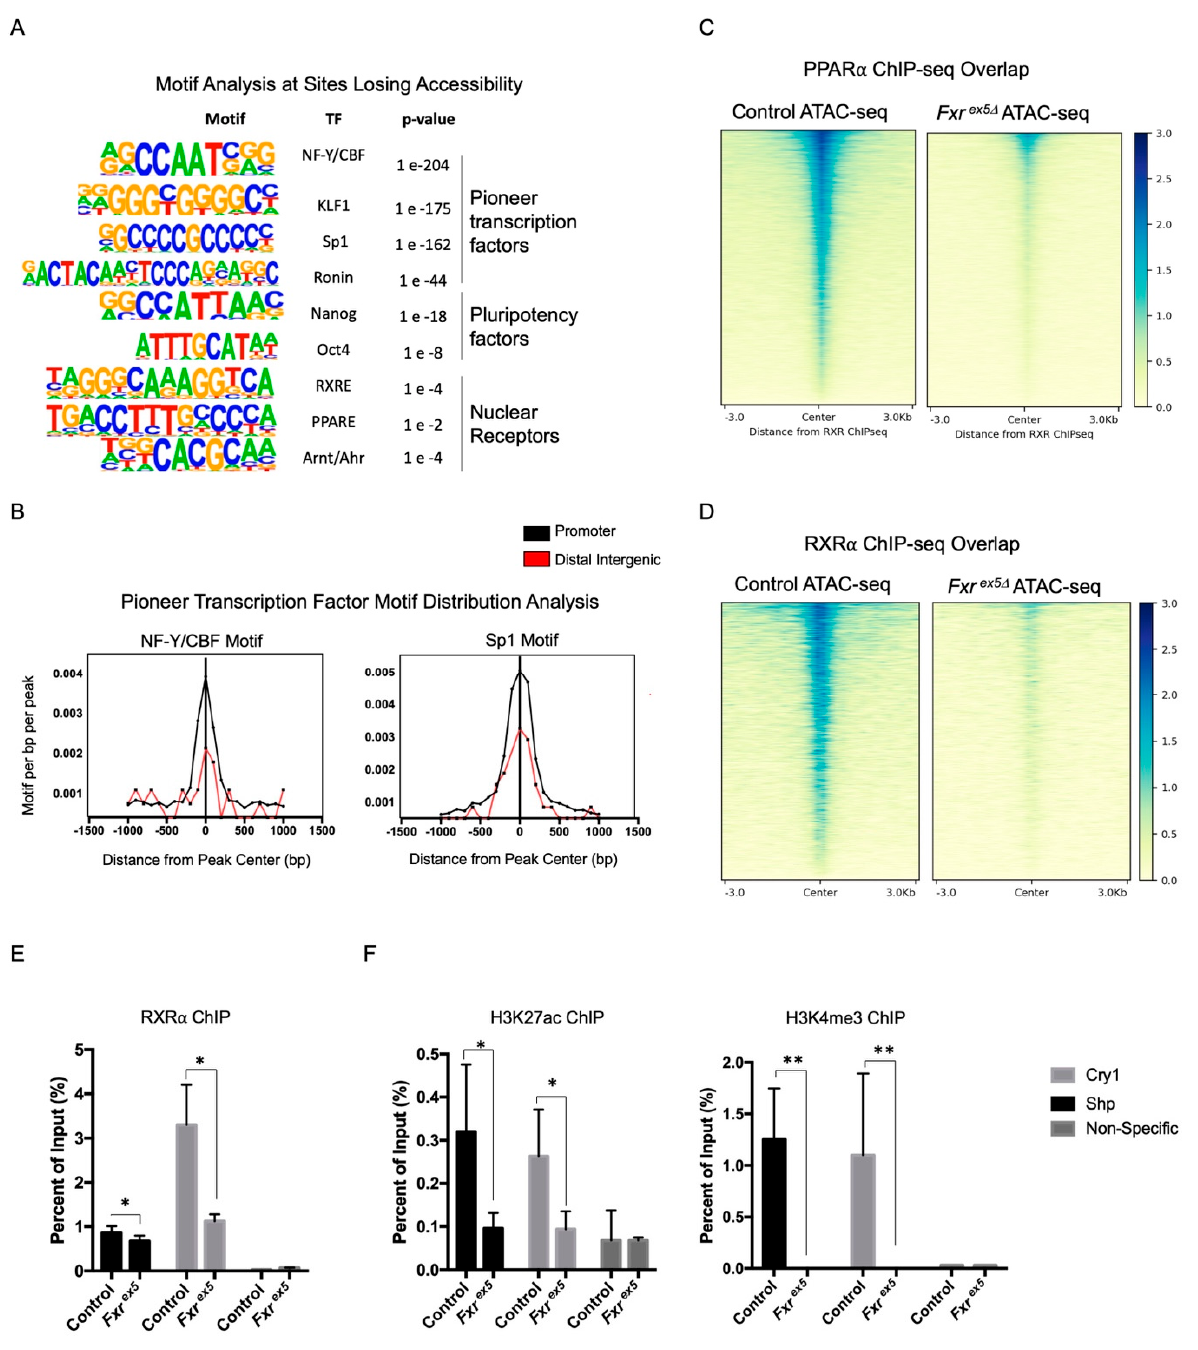
Figure 3. Loss of FXR affects chromatin accessibility at transcription factor binding sites and the recruitment of transcription factors. ( A ) Motif enrichment analysis of top sites losing accessibility upon FXR deletion. ( B ) Motif distribution analysis on promoter or distal intergenic regions for peaks losing accessibility with FXR deletion. ( C , D ) Overlap in chromatin accessibility in control and Fxr ex5 Δ ATAC-seq and ChIP-seq peaks of transcription factors PPAR α ( C ) and RXRa ( D ) The ATAC-seq signal intensity heatmap depicts profile of transcription factor binding at sites of chromatin accessibility in control and Fxr ex5 ∆ hepatocytes. ( E , F ) ChIP at the promoters of Nr0b2 genes using antibodies specific for RXRa ( E ), H3K27 acetylation or H3K4 trimethylation ( F ) in control and Fxr ex5 ∆ hepato- cytes. A control region in the Hic1 locus was used as a negative control for the test. All ChIP exper- iments were performed using hepatocytes from three separate male animals ( n = 3). Student T-test was performed in order to determine statistical significance relative to controls: * p < 0.05, ** p < 0.01. 3.4. FXR Deletion Leads to Dysregulation of the Bile Acid and Circadian Rhythm Pathways